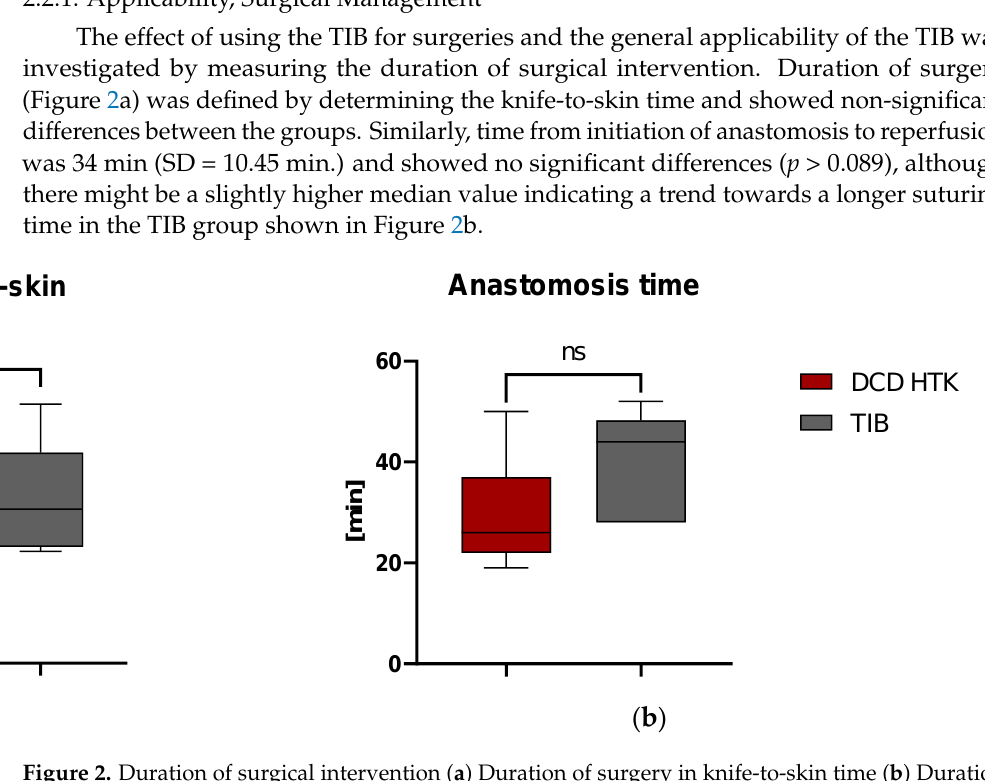
Figure 2. Duration of surgical intervention ( a ) Duration of surgery in knife-to-skin time ( b ) Duration of anastomosis time before reperfusion. Values are reported with their respective median and 95% confidence interval. DCD = Donor after cardiac death.